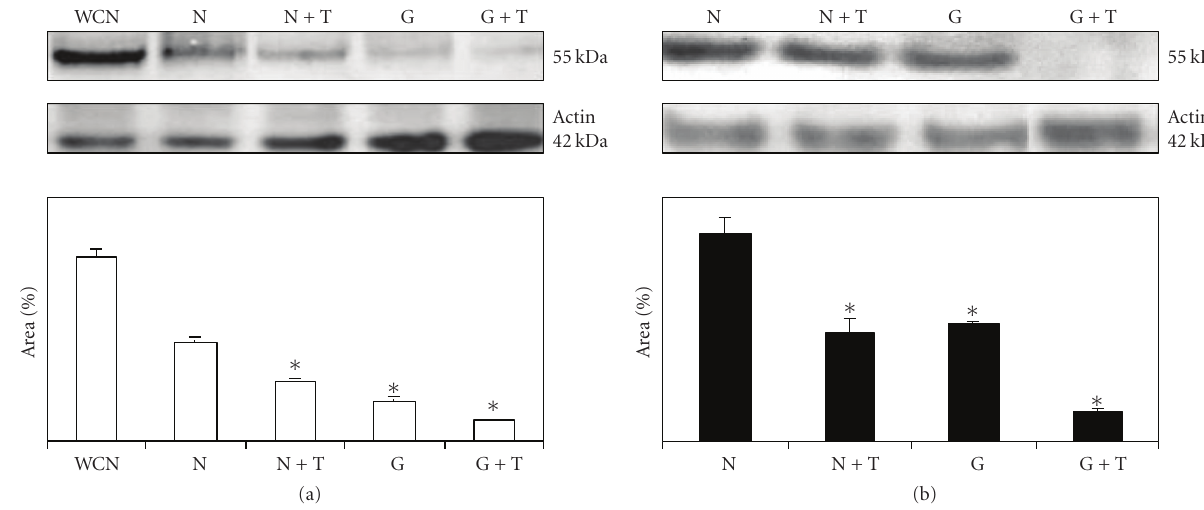
Figure 4: Western blot to detect GLUT1 transporter protein expression in homogenates from normal placental villi, cultured for 24 hours (a) and 48 hours (b). Actin presence was also detected as a positive control for protein content in samples. GLUT1 expression was evaluated with the “Scion Image for Windows” program that measured the area units marked. WCN: without culture normal placental villi (positive control); N: normal placental villi; N + T: normal placental villi cocultured with T. cruzi; G: normal placental villi cultured under high glucose media; G + T: normal placental villi cocultured with T. cruzi under high glucose media. Values shown are the mean ± SE. ∗ Significantly di ff erent from the control ( P < 0 . 05; n = 8; ANOVA